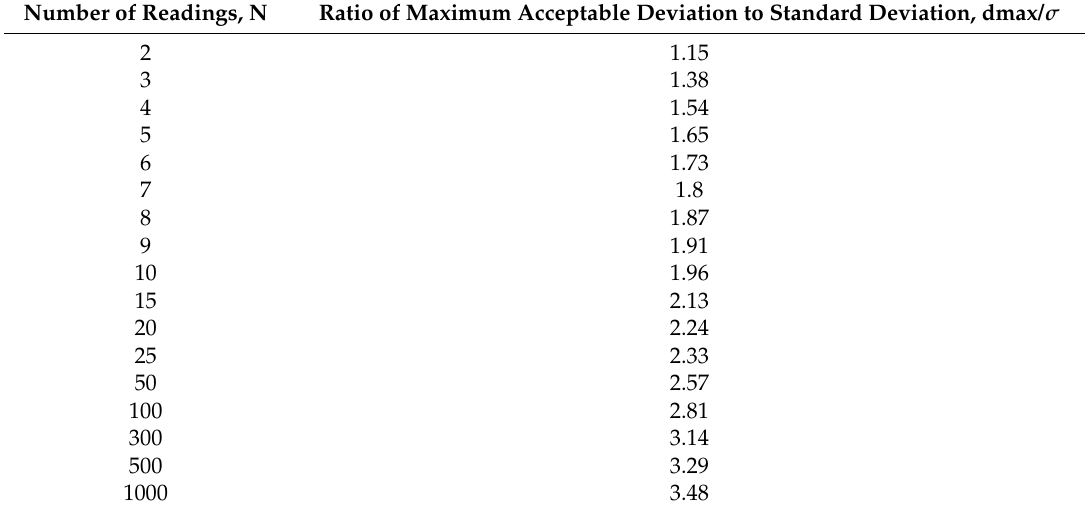
Table 3. Chauvenet’s Criterion for rejecting a